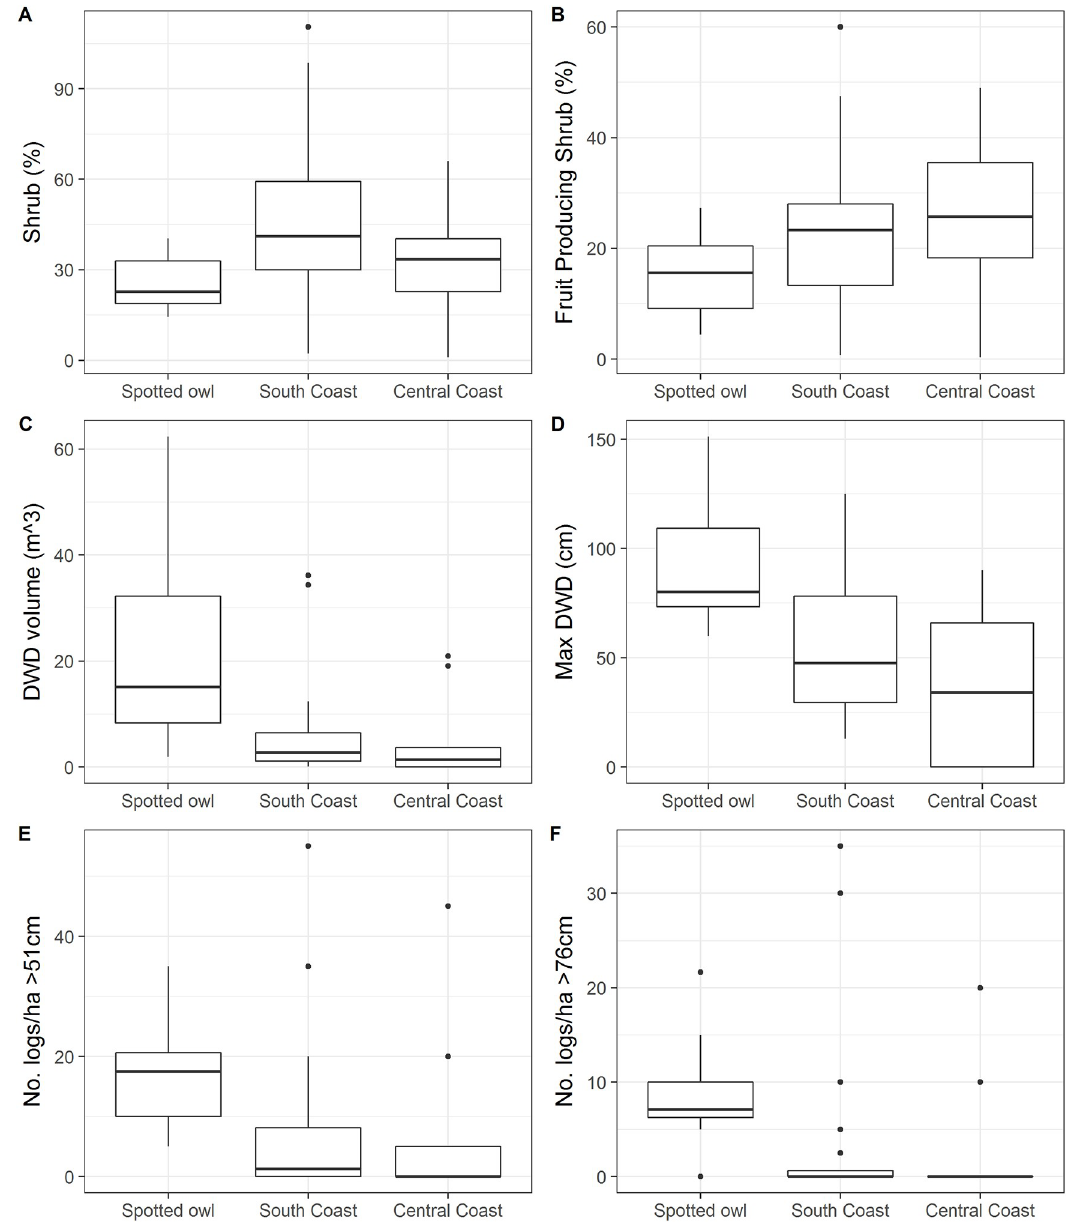
Fig 4. Vegetation data—Understory. Comparison of understory shrubs and logs, including downed woody debris (DWD) characteristics at northern spotted owl ( Strix occidentalis caurina ) and a coastal subspecies of Pacific marten ( Martes caurina humboldtensis ) sites in coastal Oregon. Box plots show maximum and minimum values (end of lines or extreme points), first and third quartiles (top and bottom line of box), and the median (line within